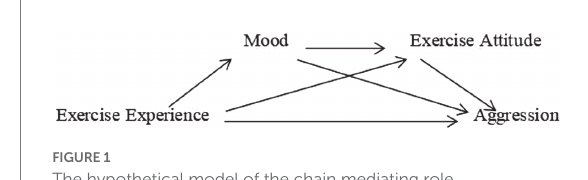
FIGURE 1 The hypothetical model of the chain mediating